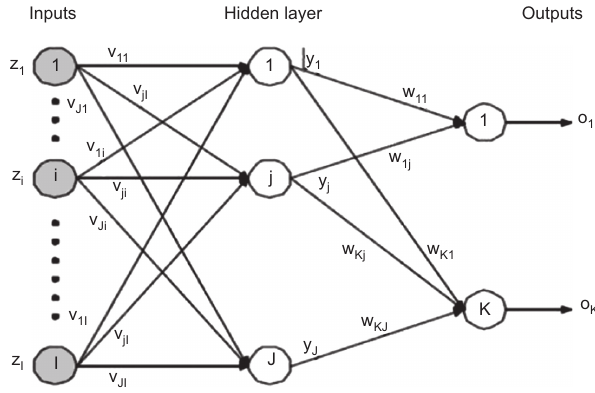
second (hidden) layer of neurons. Thereafter, the data are sent via more syn- apses to the third layer of output neurons. More complex systems will have more layers of neurons with some having increased layers of input neurons and output neurons. The synapses store parameters called “weights” that manipulate the data in the calculations. Figure 3 shows weight matrix [ v ] between the input and hidden layers and weight matrix [ w ] between the hidden and output layers. Train- ing of the neural network updates these weights. Supervised training is used for